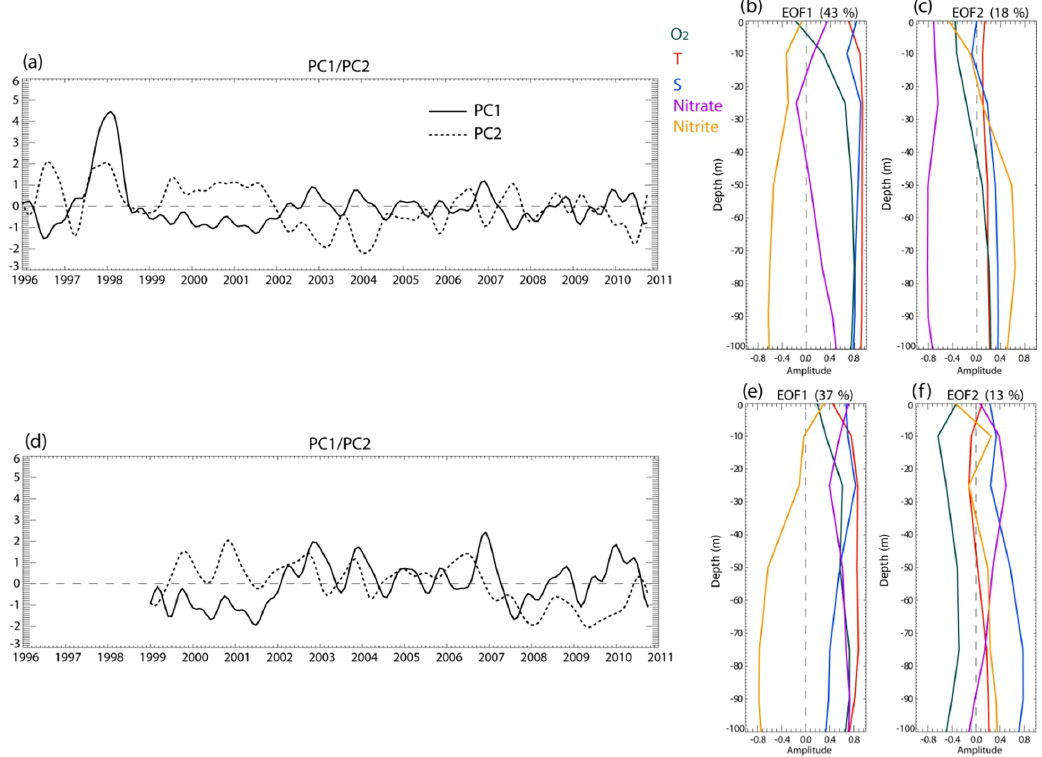
Figure 9. Combined EOF analysis of temperature, salinity, oxygen, nitrate and nitrite for the periods (top) 1995–2010 and (bottom) 1999– 2010. (a, d) PC time series and (b, c, e, f) mode patterns for the first two EOF modes. A 6-month low-pass filter was applied to the data, and the data were normalized prior to carrying the EOF analysis so that the unit is dimensionalized.